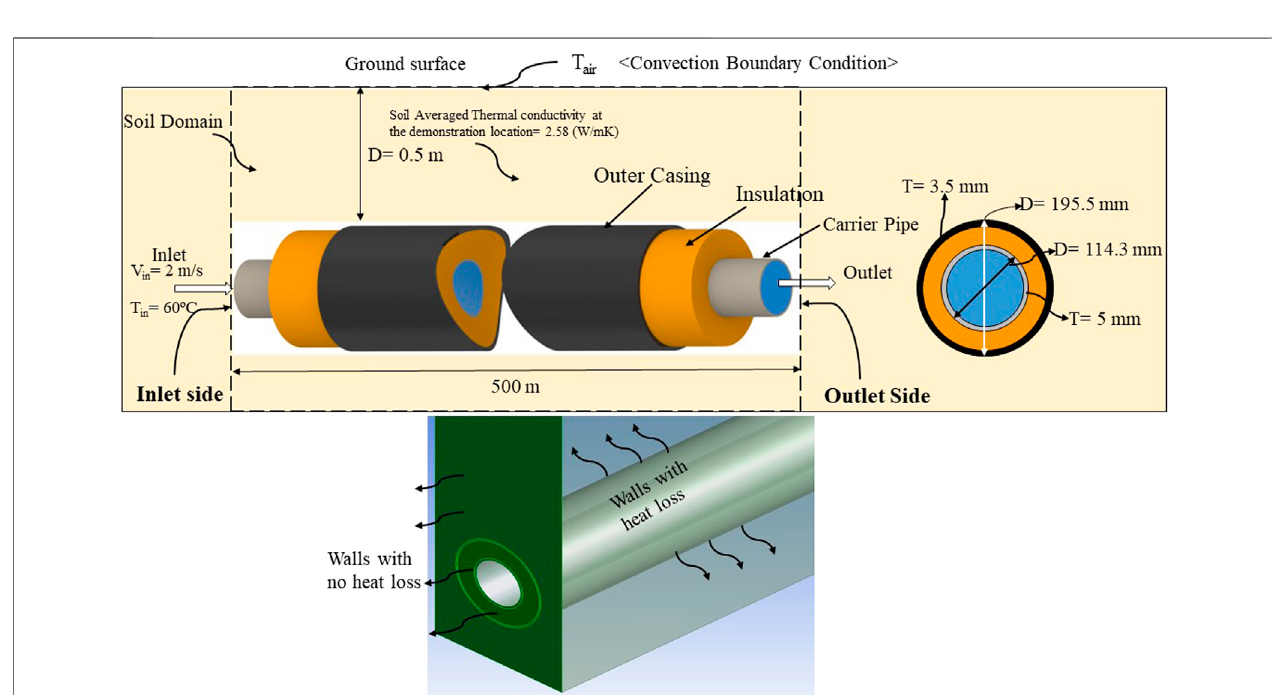
FIGURE 2 | Schematic and the ANSYS model of the simulated computational domain along with boundary conditions.